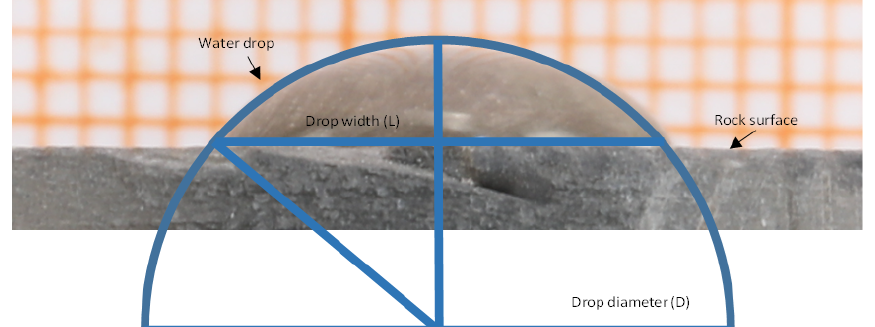
Figure 1. Scheme of the contact angle